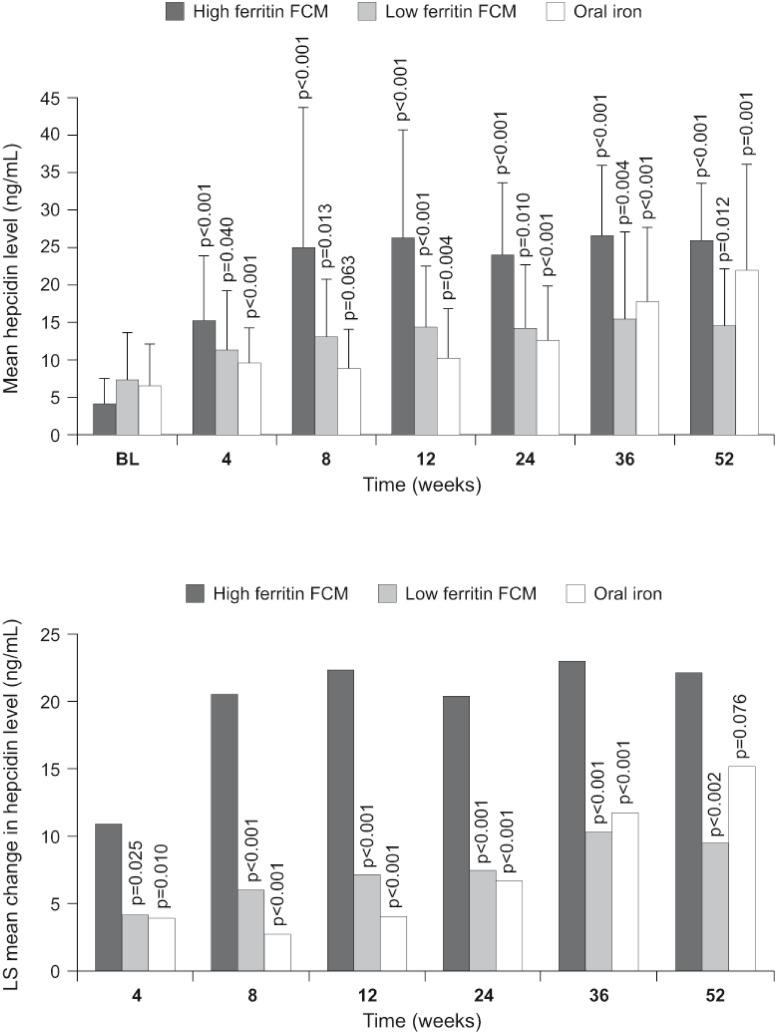
(a) Observed mean (SD) hepcidin level at each visit by treatment group. The p values indicate change from baseline (student paired t test). (b) Least square [LS] mean change in hepcidin level from baseline to each visit by treatment group by a mixed model with repeated measures procedure, with treatment group and baseline hepcidin as covariates. The p values refer to the comparison of change from baseline in the low ferritin FCM group or oral group versus the high ferritin FCM group. All differences between the low ferritin FCM and oral iron groups for the mean change in hepcidin level from baseline were non-significant (p>0.05). In both graphs, only values obtained prior to the start of alternative anemia therapy are included.